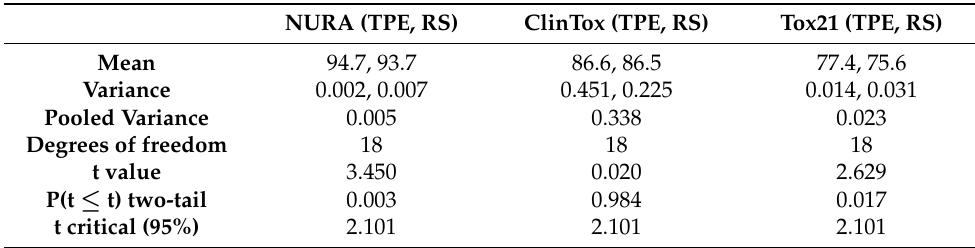
Table A6. Two-tailed t-test with a hypothesized zero mean difference for the three datasets consider- ing the best result among 10 replicas between tree-structured Parzen estimator (TPE) and random search (RS) on an external test set. Variances were assumed